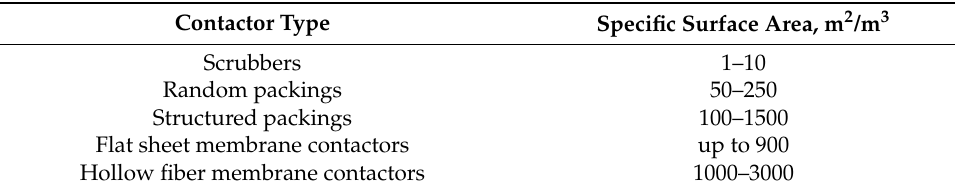
Table 4. Specific surface area for different gas-liquid